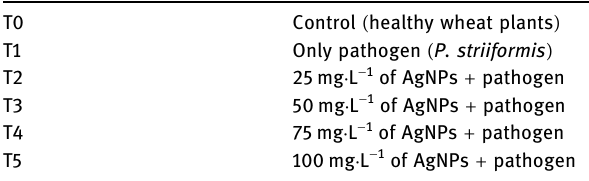
Table 2: Treatment layout for evaluation of disease severity and AgNPs concentrations